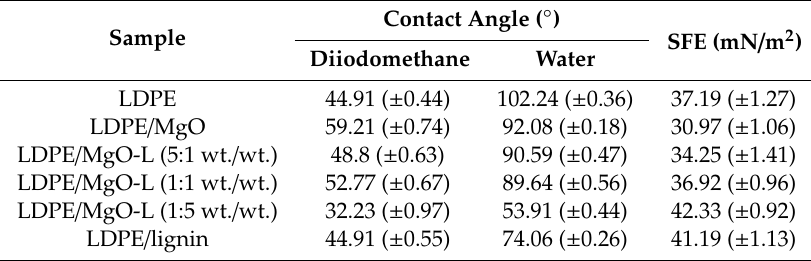
Table 3. Diiodomethane and water contact angles and the surface free energy of the adhesion of the